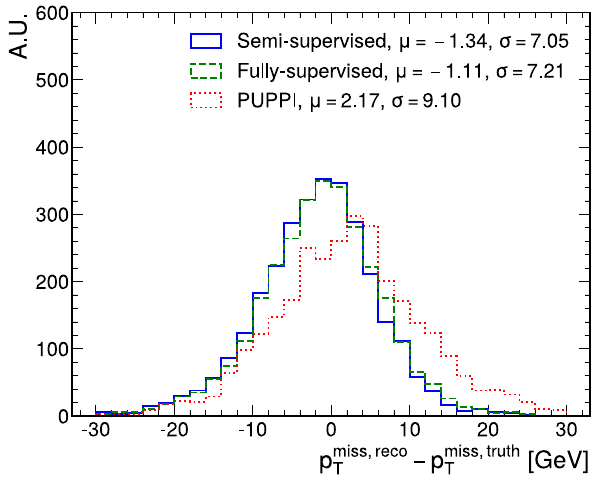
Fig. 6 Resolution of the missing transverse momentum of events for the different pileup mitigation models for n PU =